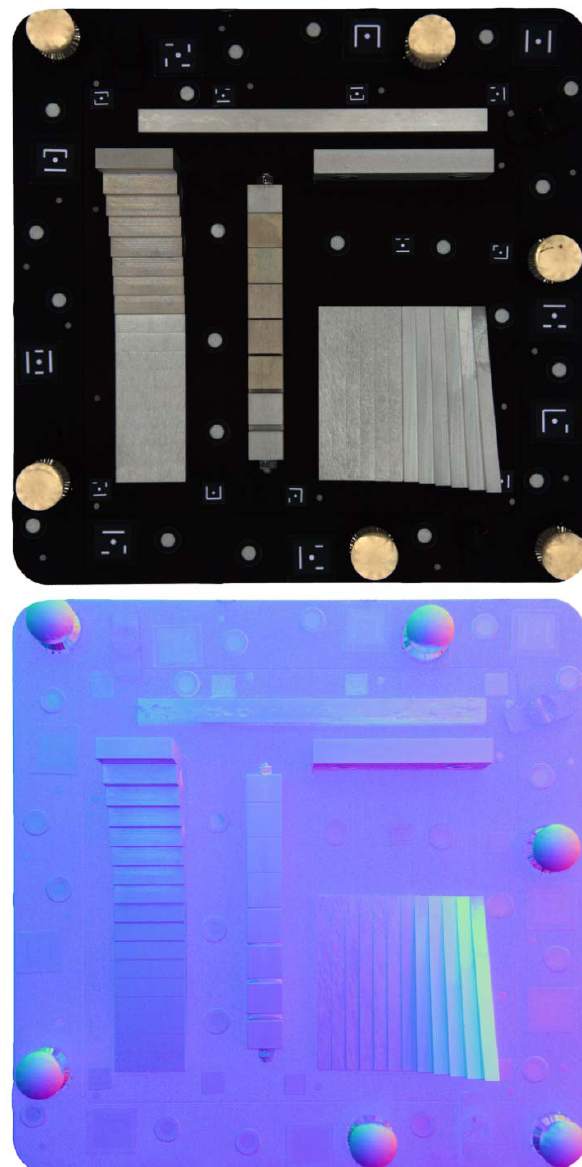
Figure 7. Albedo (top) and normal vectors (bottom) for the 3D test object, generated by the bounded regression technique. The resulting albedo (Fig. 7 top) is nearly achromatic, except for the beige surface of the tooling balls. The surface normal vectors (Fig. 7 bottom), shown in conventional false colour coding, appear constant in each planar surface of the step targets, and only the spherical tooling balls exhibit a large range of angles. A further correction to the normals is needed to compensate for the wide angle of view of the lens, which with a sensor width of 24.6 mm and principal distance of 35.04 mm is 38.7° across the full image width. The projective imaging geometry means that the normals are computed with respect to the rays converging from the object through the perspective centre of the lens (Fig. 8). To transform them to a parallel imaging geometry, each normal needs to be rotated outwards from the Z axis by an angle corresponding to the distance of the pixel from the centre of the image plane. The operation is conveniently applied as a vector rotation, using the Rodrigues formula, and can be optimised in Matlab by treating the whole image as an